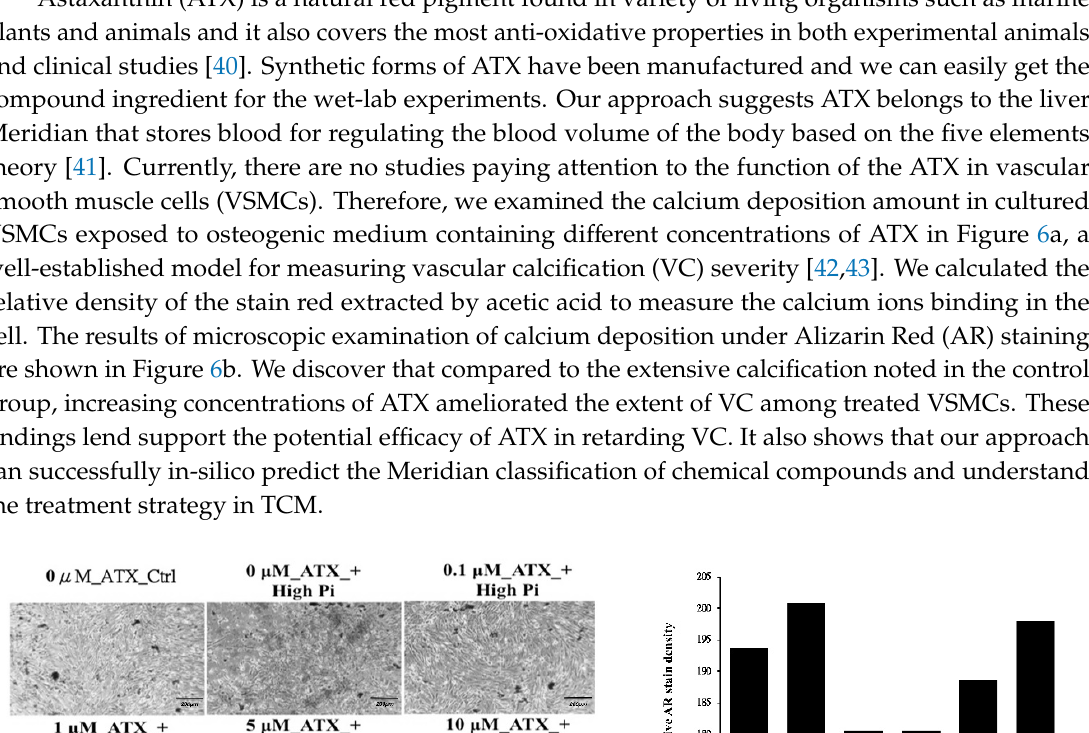
Figure 5. The major substructure of the heart Meridian exists in the component of the herb Lily Bulb, Colchicine .